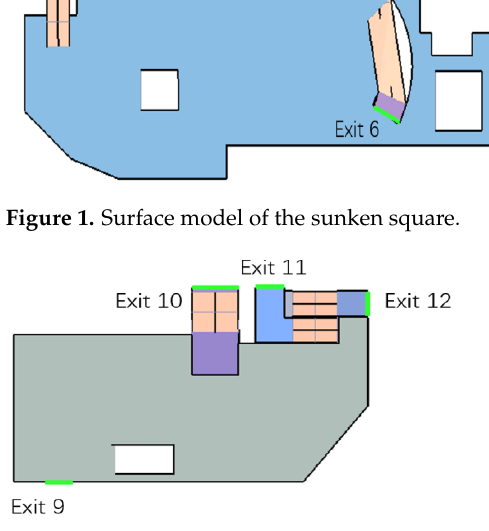
Figure 2. Surface model and export instructions.